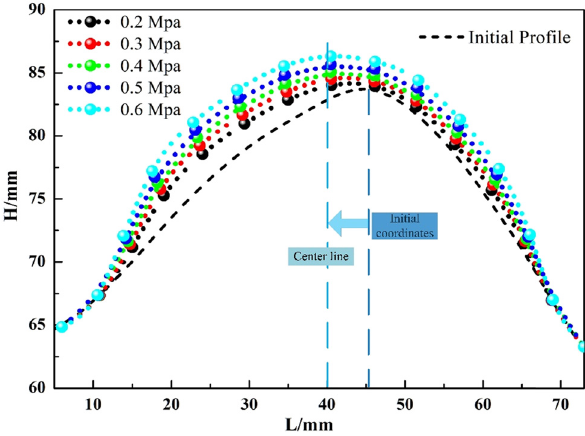
Figure 10: Bump pro fi le under di ff erent